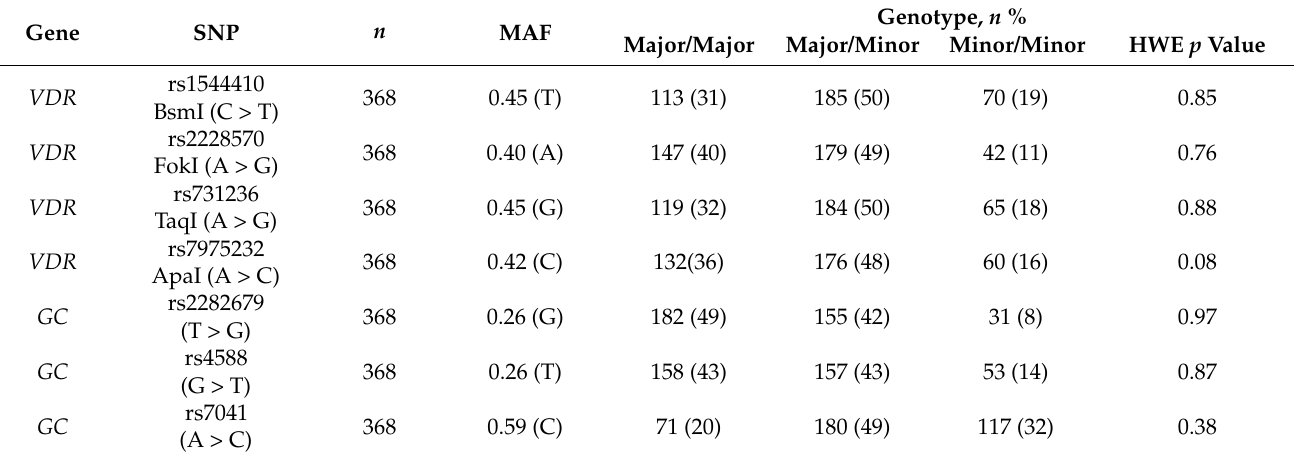
Table 2. Reference SNP numbers, minor allele frequencies (MAFs) and genotype.